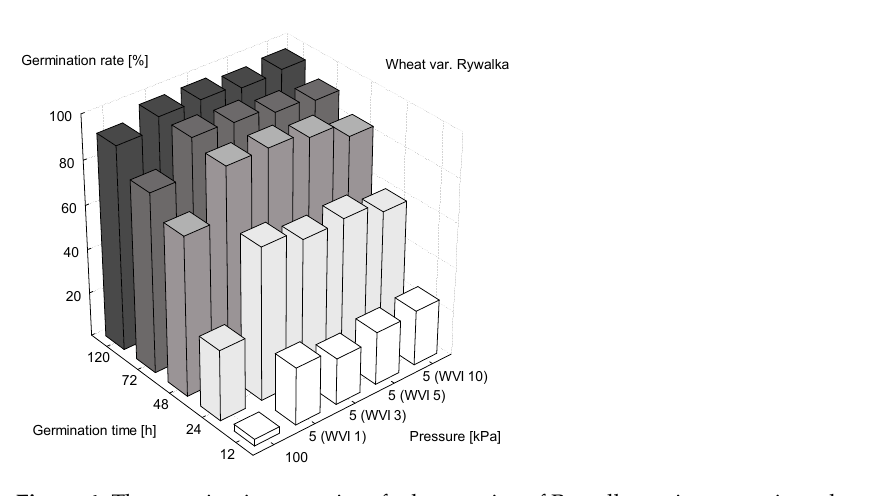
Figure 4. The germination capacity of wheat grains of Rywalka variety over time, depending on the impregnation method (WVI 1—1 cycle of WVI, WVI 3—3 cycles of WVI, WVI 5—5 cycles of WVI, WVI 10—10 cycles of WVI).